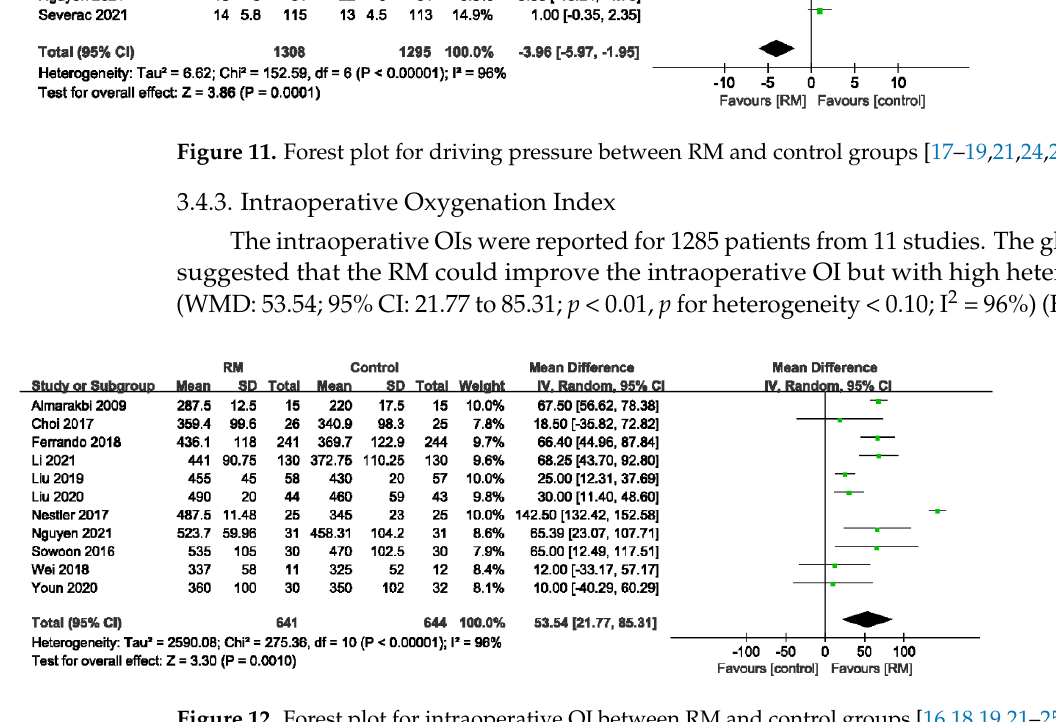
Figure 12. Forest plot for intraoperative OI between RM and control groups [16,18,19,21 – 25,29,30,32].